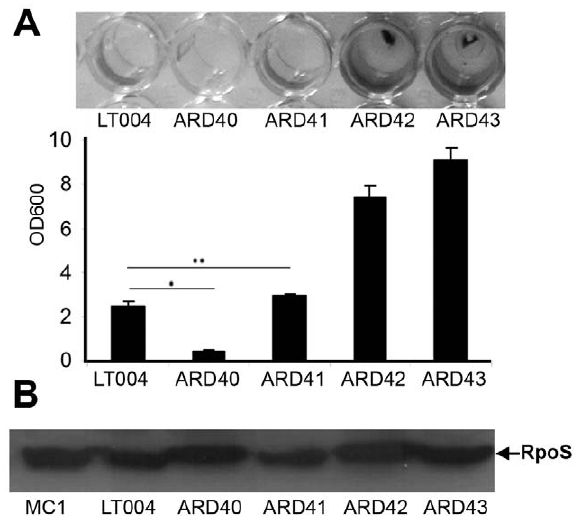
Figure 4. UPEC biofilm formation. ( A ) Crystal violet assay of biofilm formation from indicated strains. Visualization (top) and quantification (bottom) of biofilm at OD 600 . Error bars = standard deviation. * P=0.001 ** P=0.032 ( B ) Western blot of RpoS protein in indicated strains using MC1 as positive control.